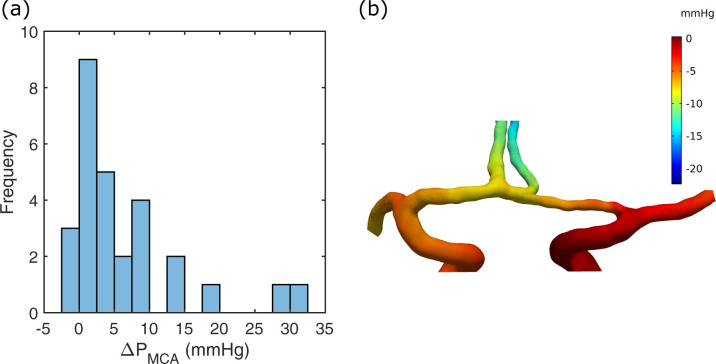
MCA pressure laterality.(a) Histogram of ΔPMCA for the patient group. (b) The CFD pressure of a stationary simulation for the case in Fig 3. A zero-reference pressure was set at the contralateral ICA, which was the right ICA inlet in this case. The ΔPMCA was 3.0 mmHg in this example.